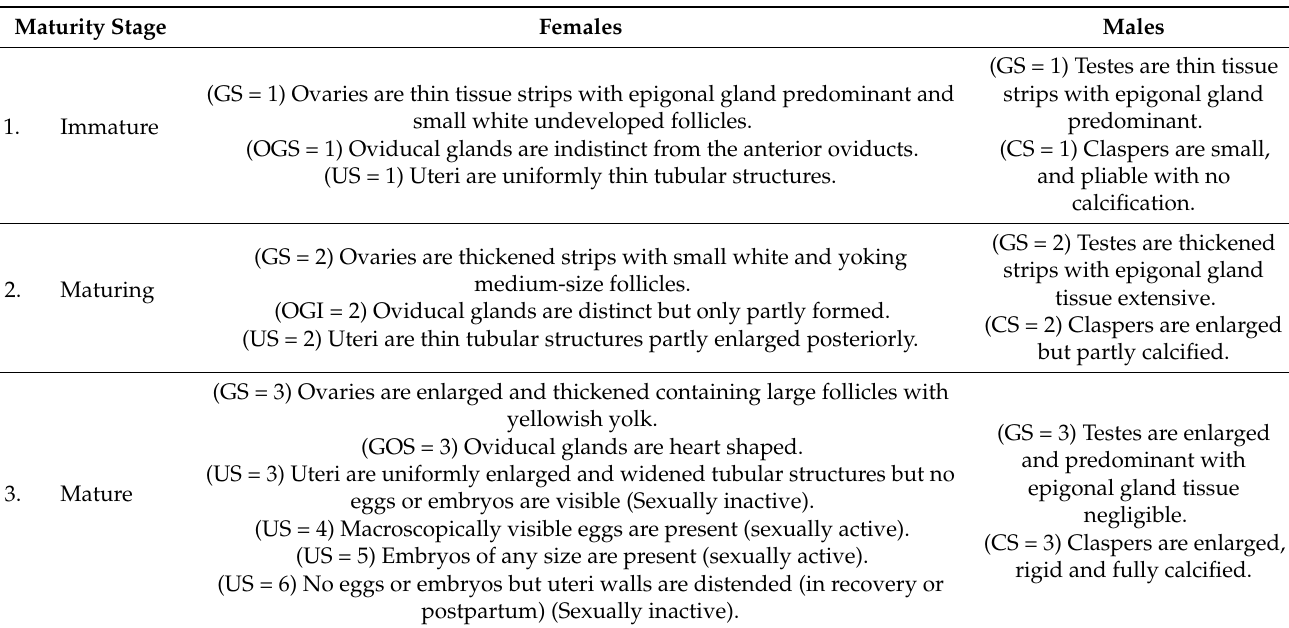
Table 1. Maturity stages of Urotrygon chilensis , adapted from 7. GS = gonad stage, OGS = oviducal gland stage, US = uterus stage, CS = clasper